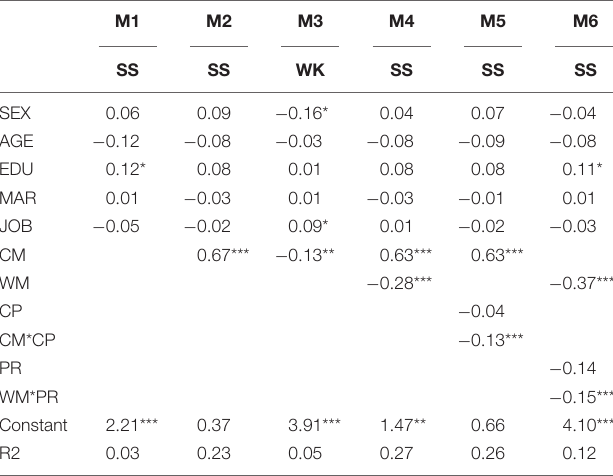
TABLE 4 | Results of hypothesis